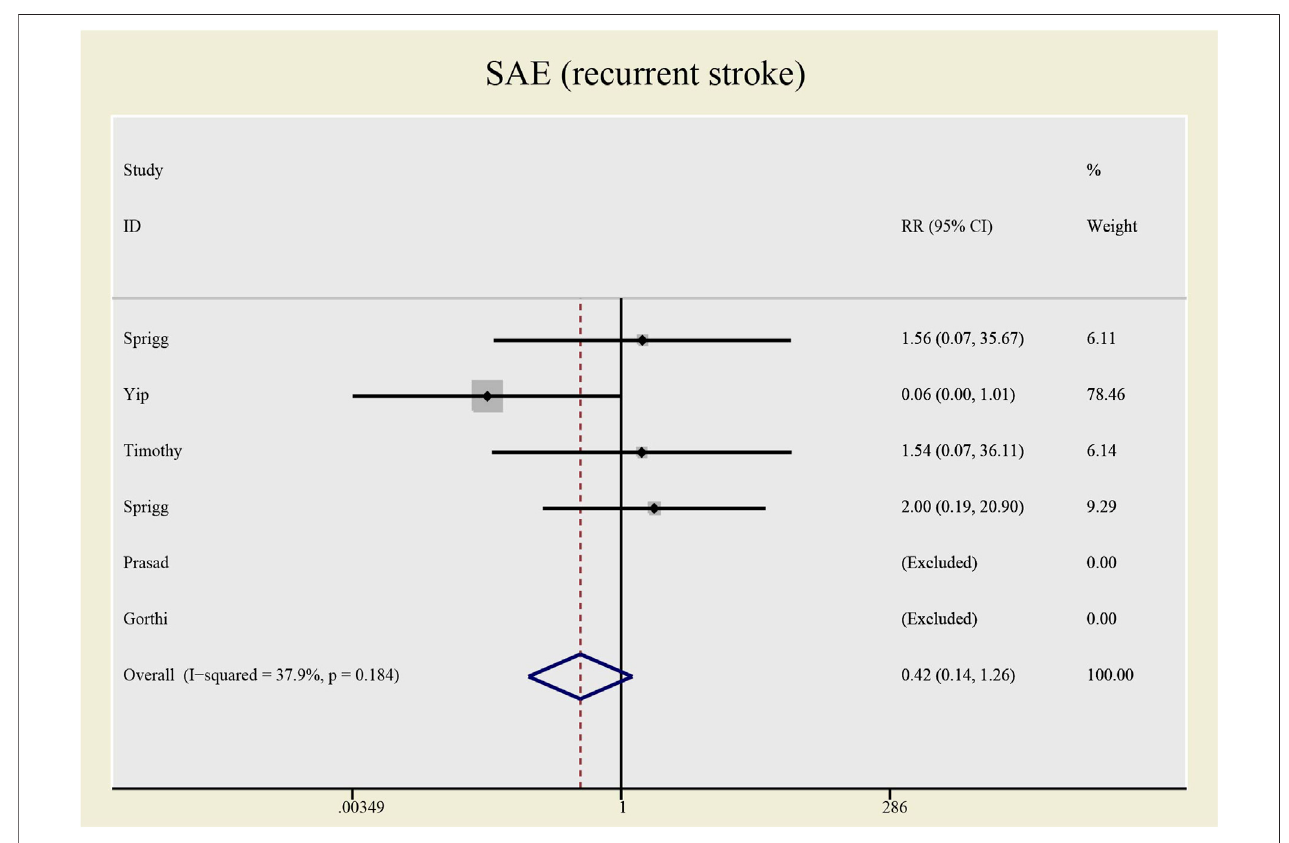
FIGURE 6 | Forrest plot for SAE (recurrent